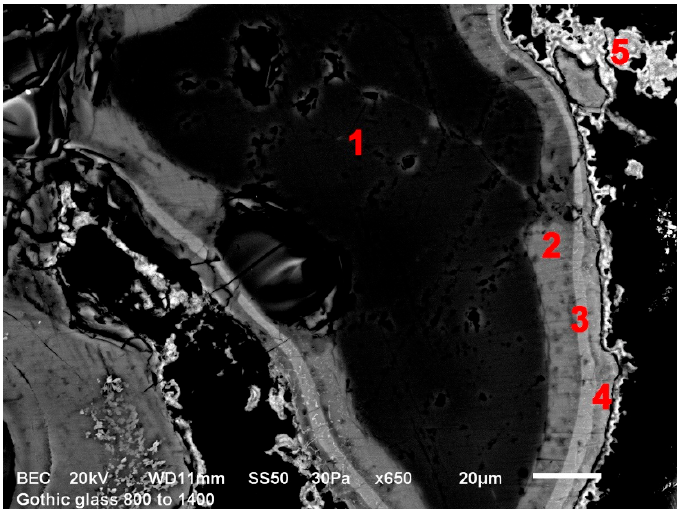
Figure 4. Model Gothic glass exposed to 800 °C, bi-product layers around SiO 2 , SEM; 1—SiO 2 core, 2—potassium silicates, 3—potassium-calcium silicates, 4—calcium-potassium silicates, 5—calcium silicates.